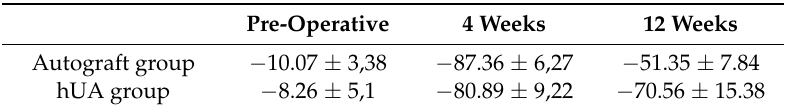
Table 1. Values of SFI ±